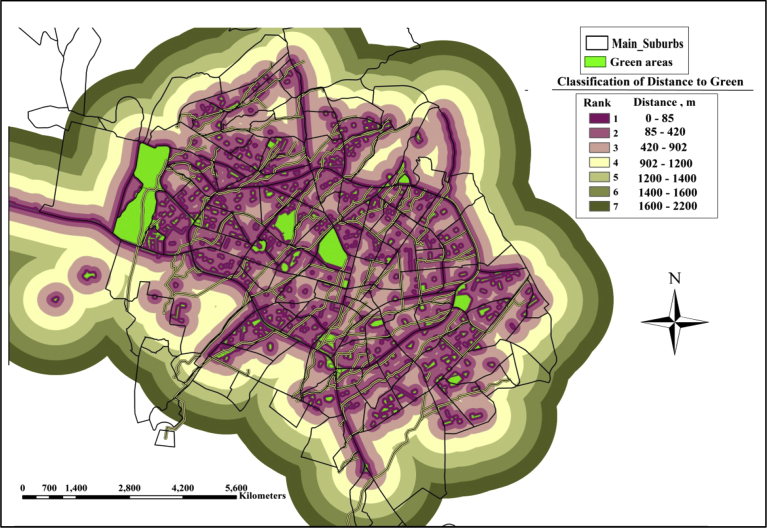
Classifications of distance to green area.